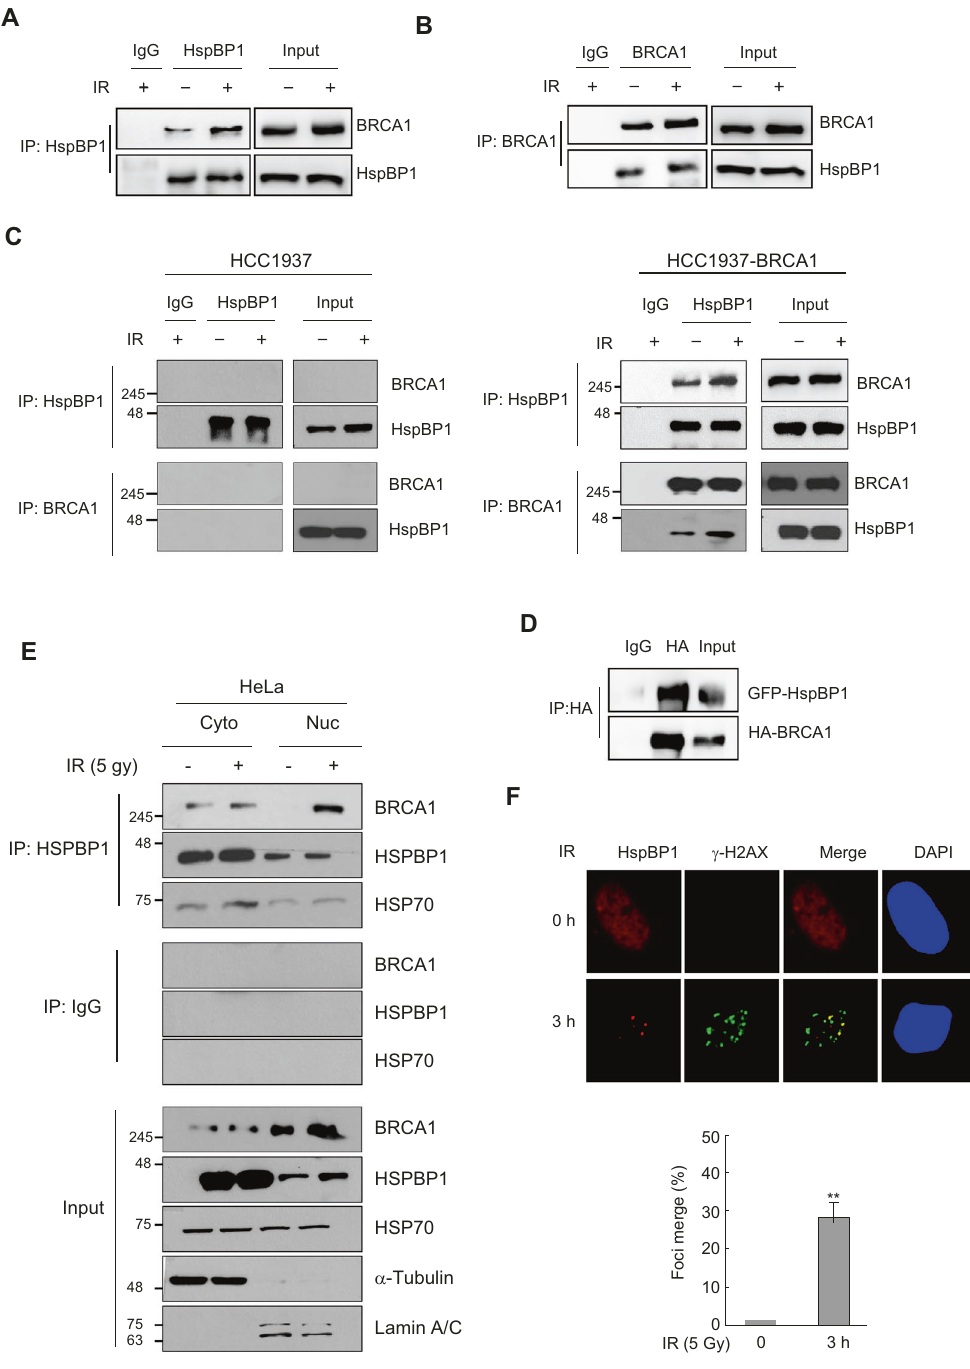
Fig. 3 HspBP1 interacts with BRCA1 and is recruited to sites of DSBs. A HeLa cells were either untreated or treated with 5 Gy of IR for 3 h, after which whole-cell lysates were subjected to immunoprecipitation with anti-HspBP1 followed by western blotting with the